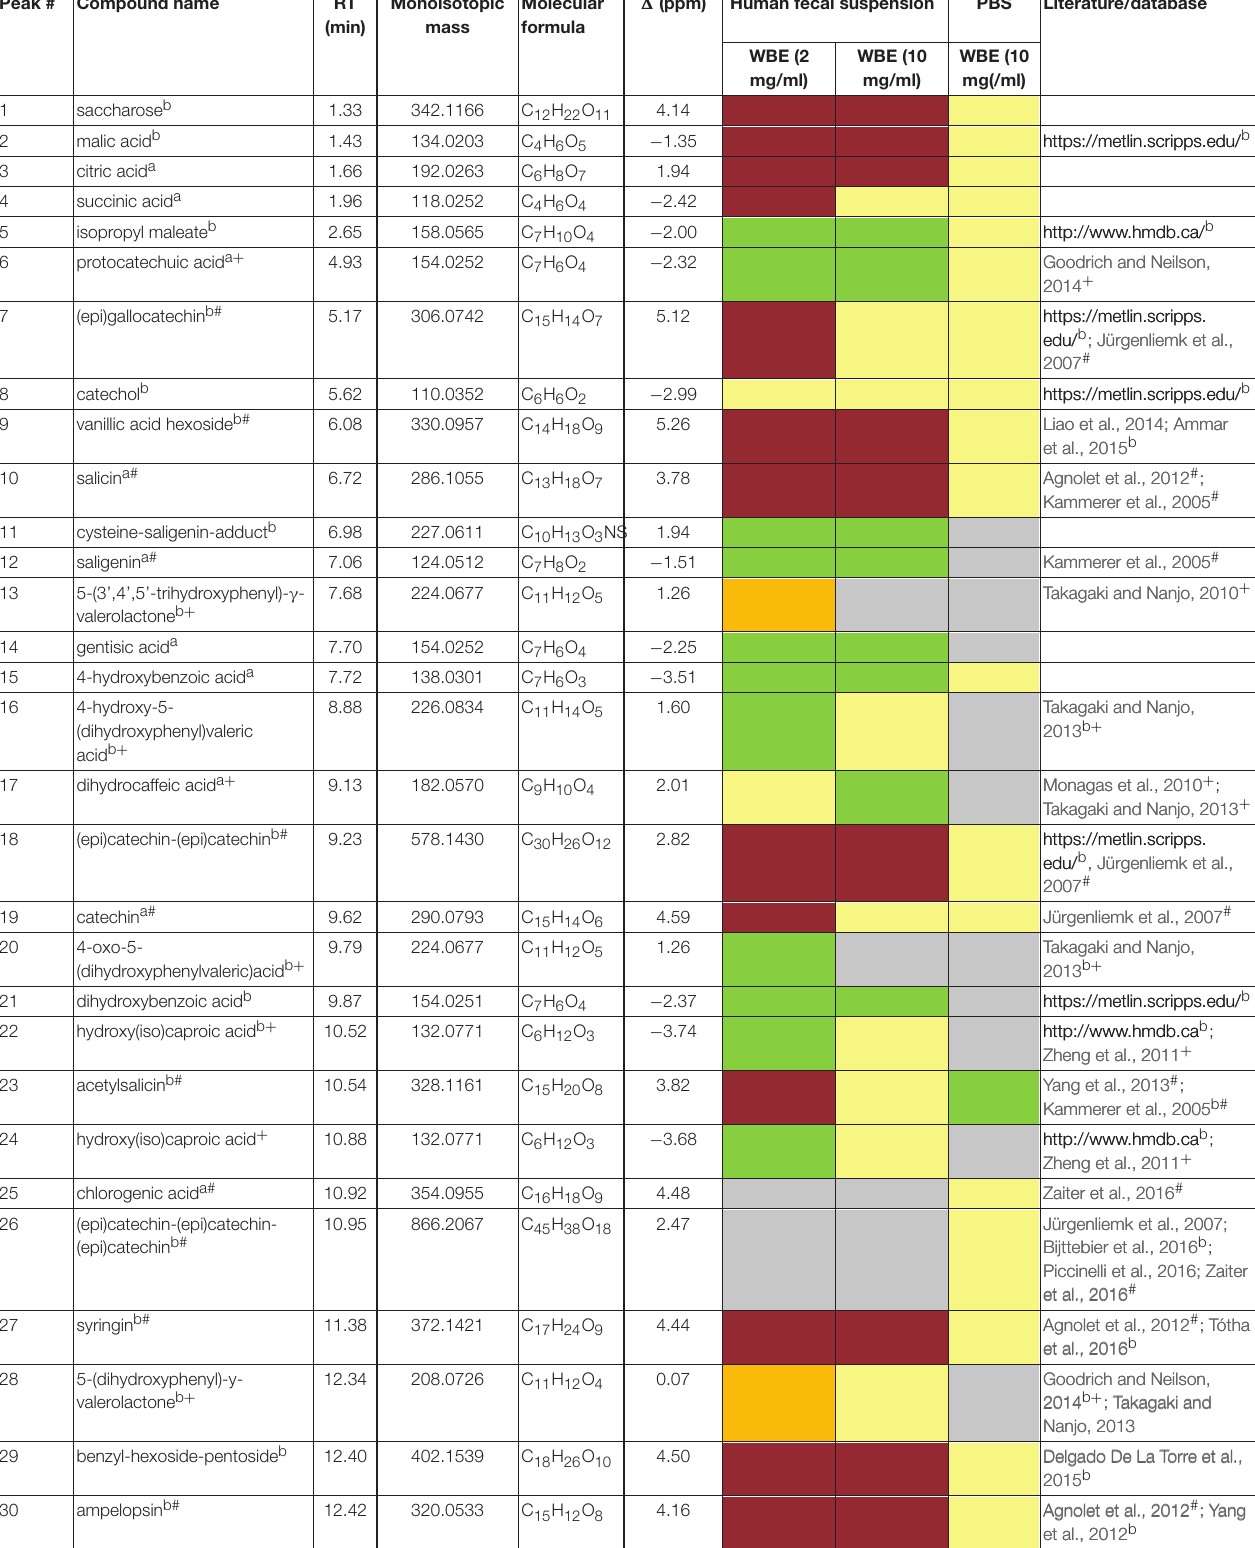
TABLE 3 | Identified compounds significantly changing over incubation